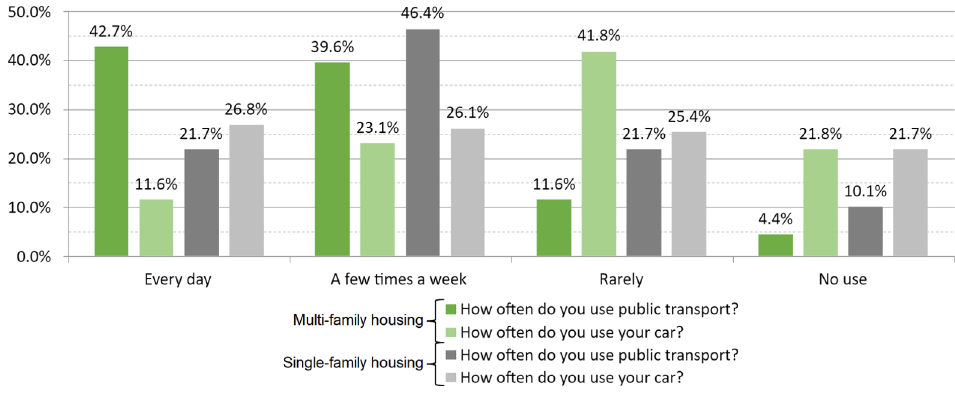
Fig. 6. Survey results chart of responses to the question How often do you use public transport or